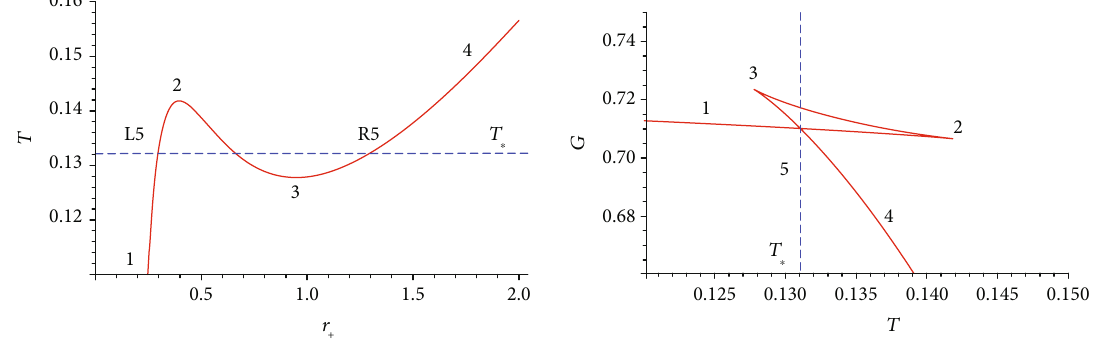
Figure 2: For n = 0 , (a) real quasinormal frequency and (b) negative imaginary quasinormal frequency as functions of N black hole with r + = 0 : 2 , R Λ = 1 , and ψ = − 5/2 in the Rastall gravity.